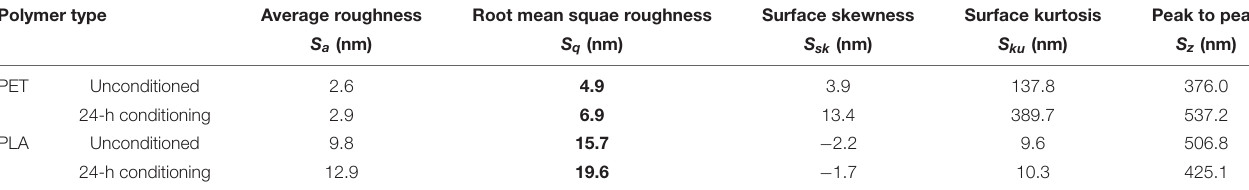
TABLE 1 | Roughness measurements calculated by SPIPTM from the AFM topography images. Polymer type